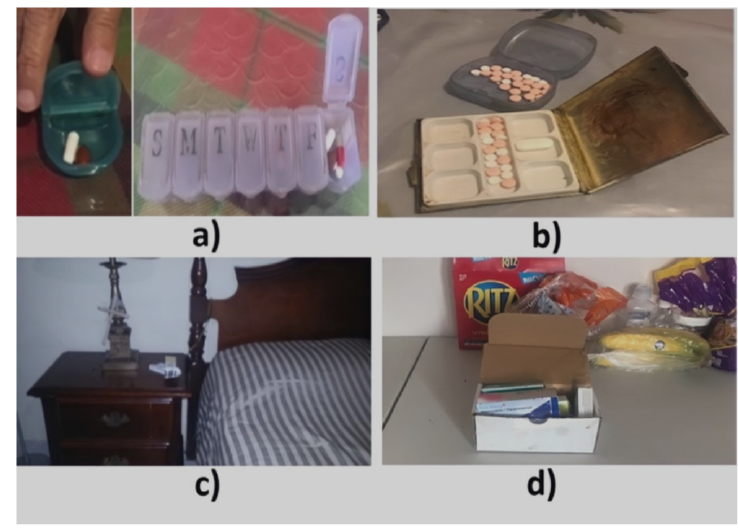
Figure 2. Locations and pill containers used by ( a ) S1, ( b ) S2, ( c ) S3, and ( d ) S4.